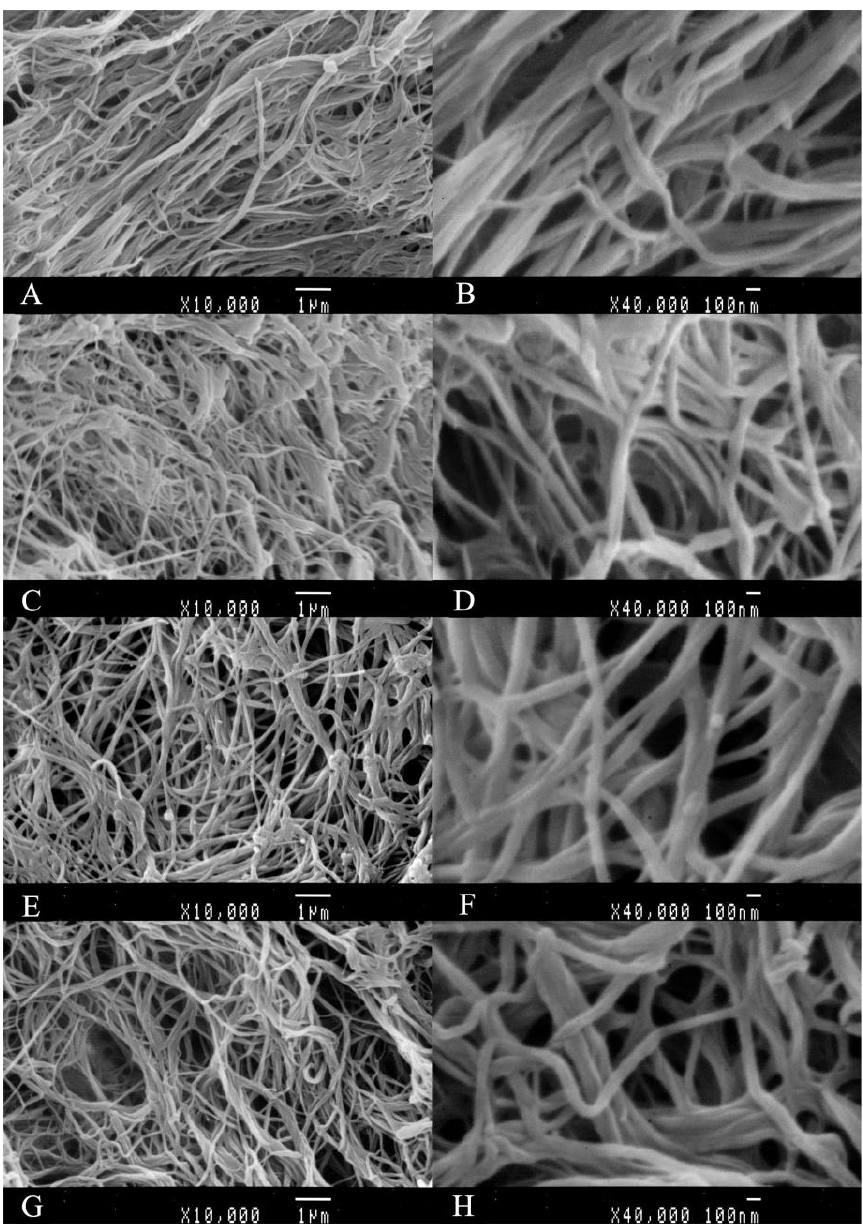
Figure 6. SEM images of resulting fibrils of ASC and PSC extracted at 4 and 12 °C from the skin of pufferfish. ( A ): ASC-4 (×10,000); ( B ): ASC-4 (×40,000); ( C ): PSC-4 (×10,000); ( D ): PSC-4 (×40,000); ( E ) ASC-12 (×10,000); ( F ) ASC-12 (×40,000); ( G ) PSC-12 (×10,000); ( H ) PSC-12 (×40,000) . Scale bars, 1 μm ( A, C, E, G ); 100 nm ( B, D, F, H ).